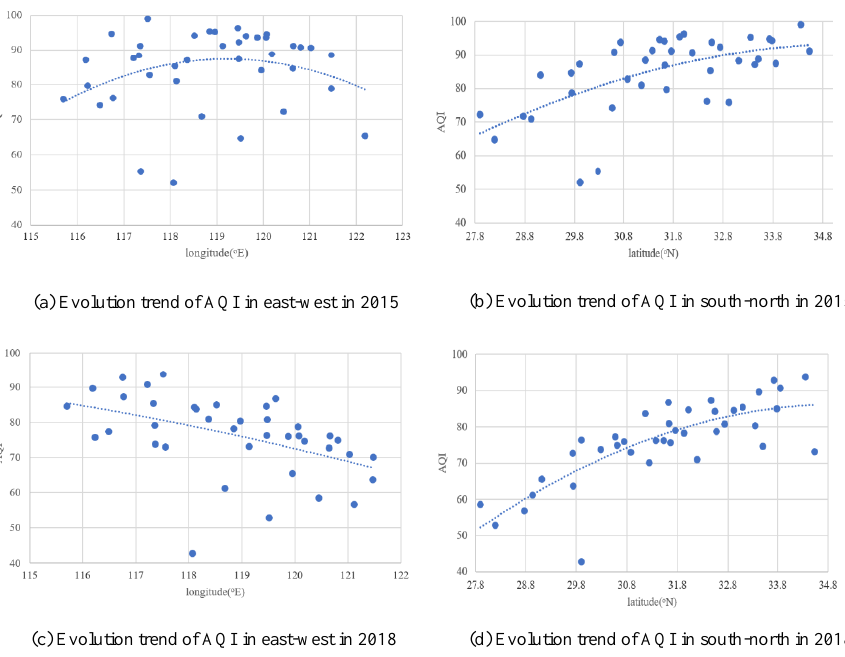
Figure 3. Spatial trend distribution of the AQI in the YRD in 2015 and 2018.